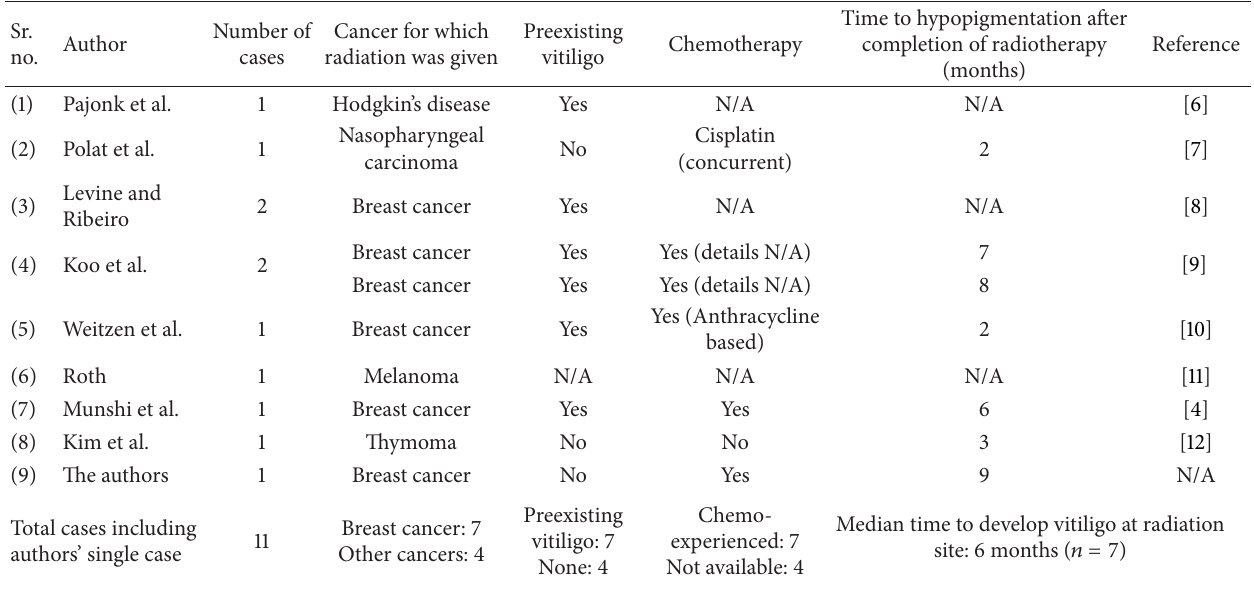
Table 1: Summary of cases of vitiligo following radiotherapy reported in the literature. Sr.